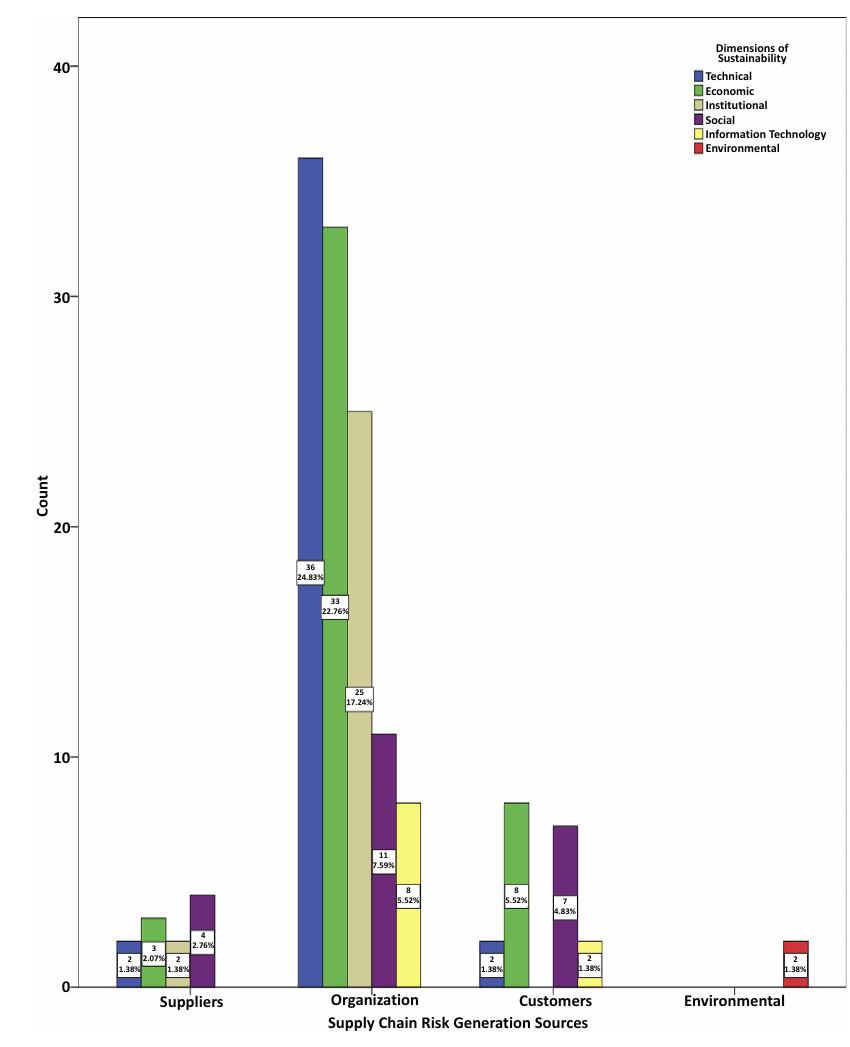
Figure 11. Distribution of semi- critical risks by different supply chain resources and